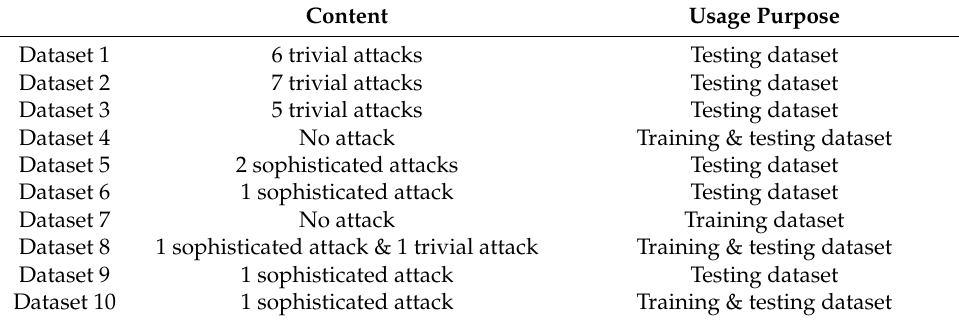
Table 2. General information of datasets used in this study. Content Usage Purpose Dataset 1 6 trivial attacks Testing